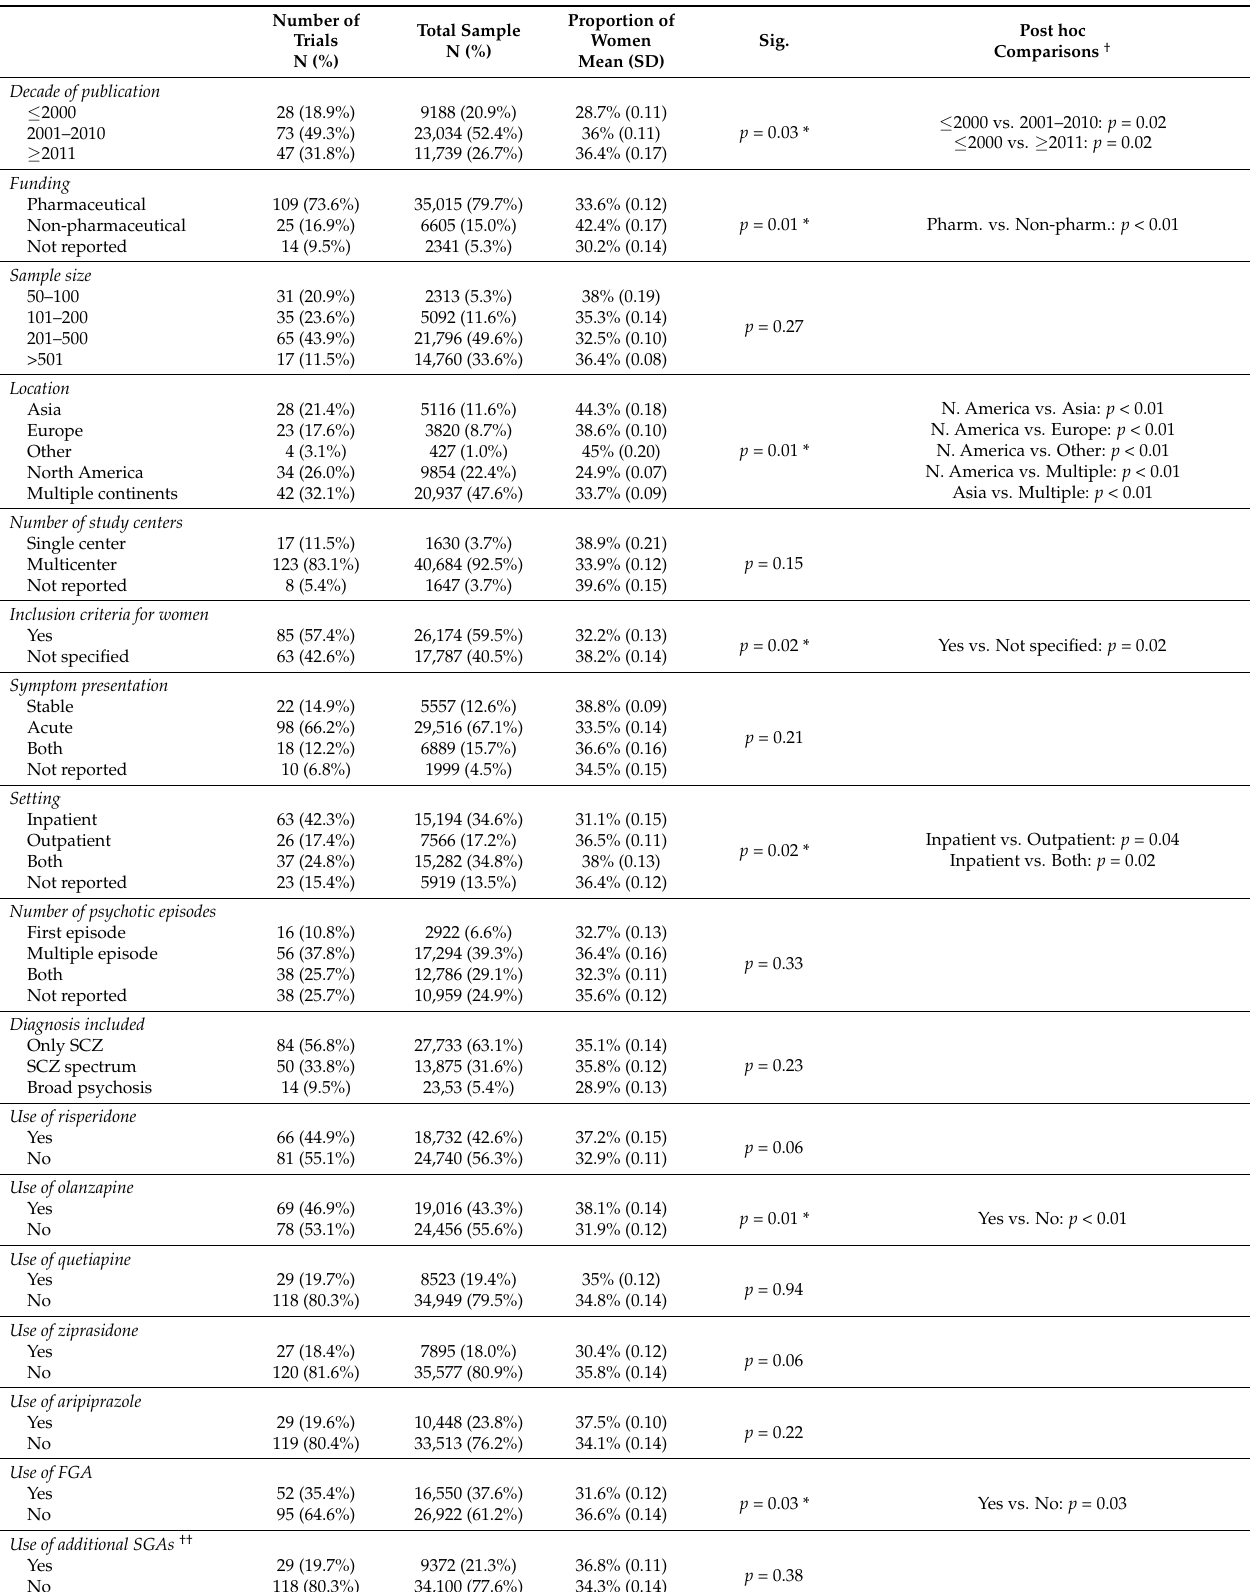
Table 2. Proportion of women by trial characteristics and one-way analysis of variance